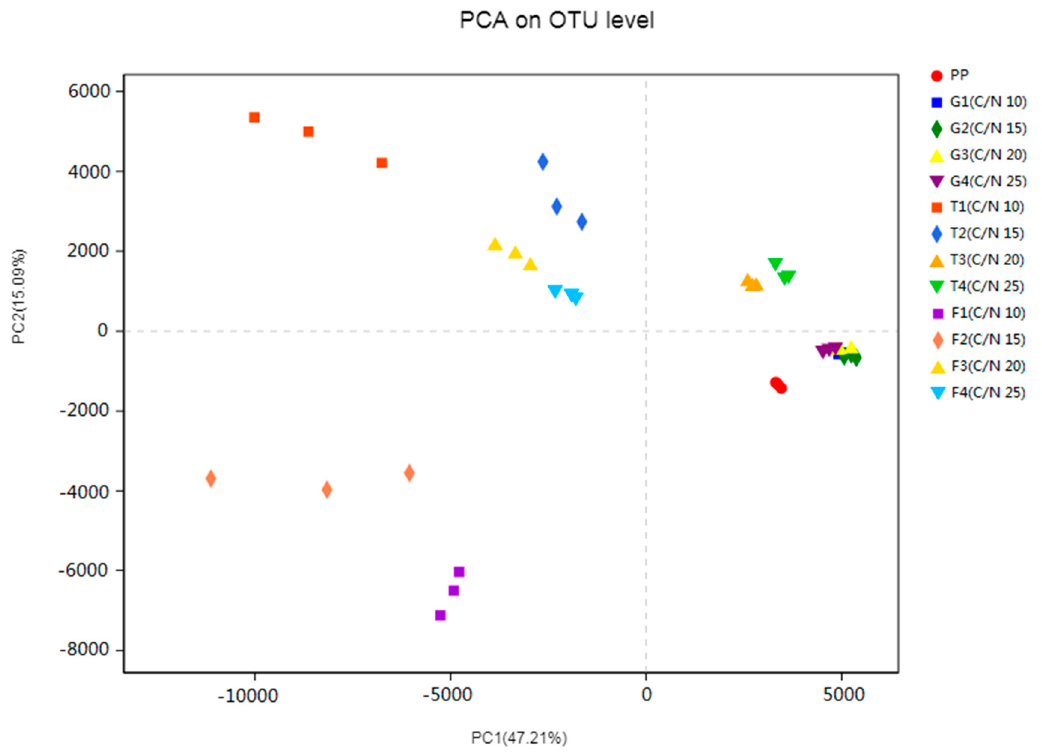
Figure 5. Principal component analysis (PCA) of bacterial community composition (operational taxonomic unit (OTU) level), PP: primeval period; G1 (C / N 10) represents the treatment of C / N 10 in GP, similarly, and so on.